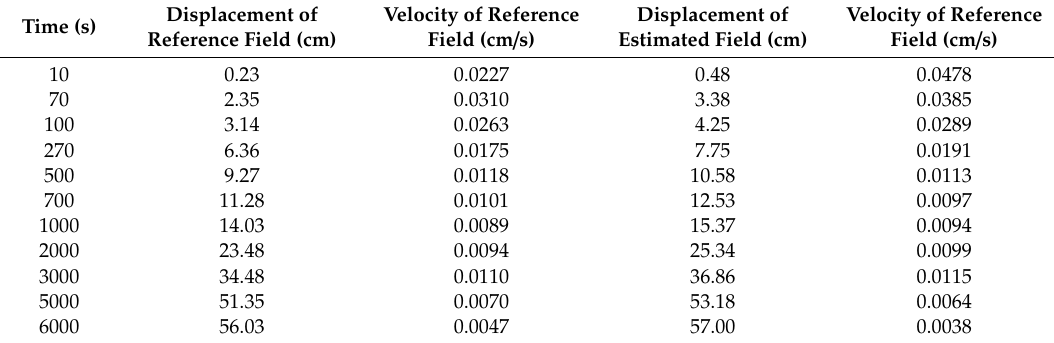
Table 2. Displacement and velocity of tracer center at different time points.